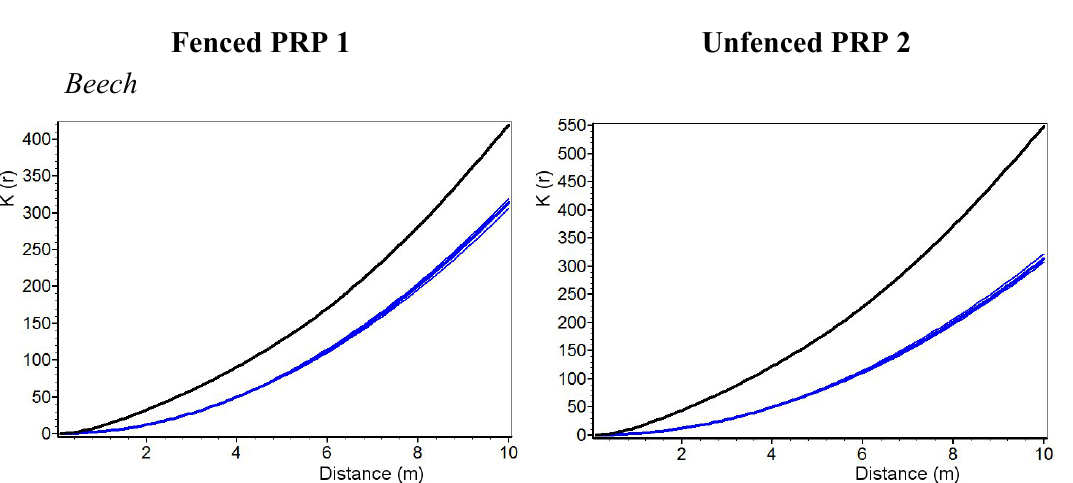
Figure 4. Horizontal structure of the natural regeneration of mixed spruce, fir and beech stand on PRPs 1 and 2, expressed by the K -function; the black line represents the K -function for real distances of trees on the PRP; the bold blue line represents the mean course for random spatial distribution of trees and the two thinner central curves represent 95% interval of reliability; when the black line of tree distribution on the PRP is below this interval, it indicates a tendency of trees toward regular distribution, and if it is above this interval, it shows a tendency toward